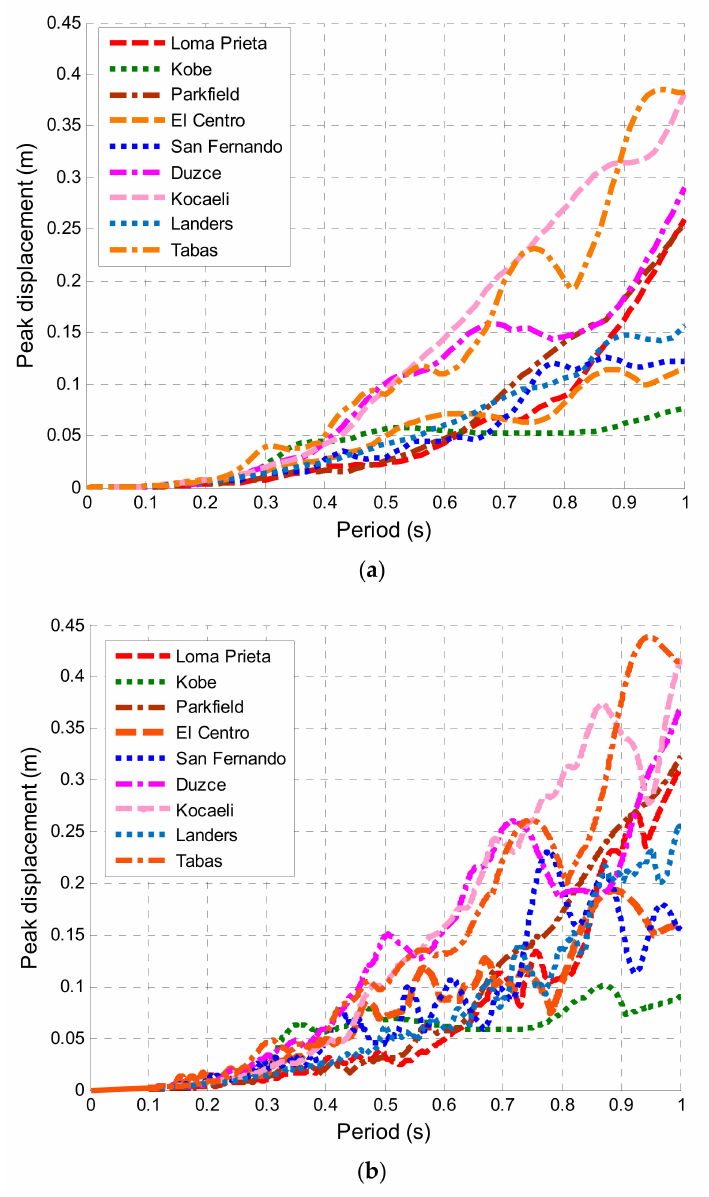
Figure 5. Peak lateral displacement with pounding ( a ) and without pounding ( b ) with relation to the natural period of the left building under di ff erent